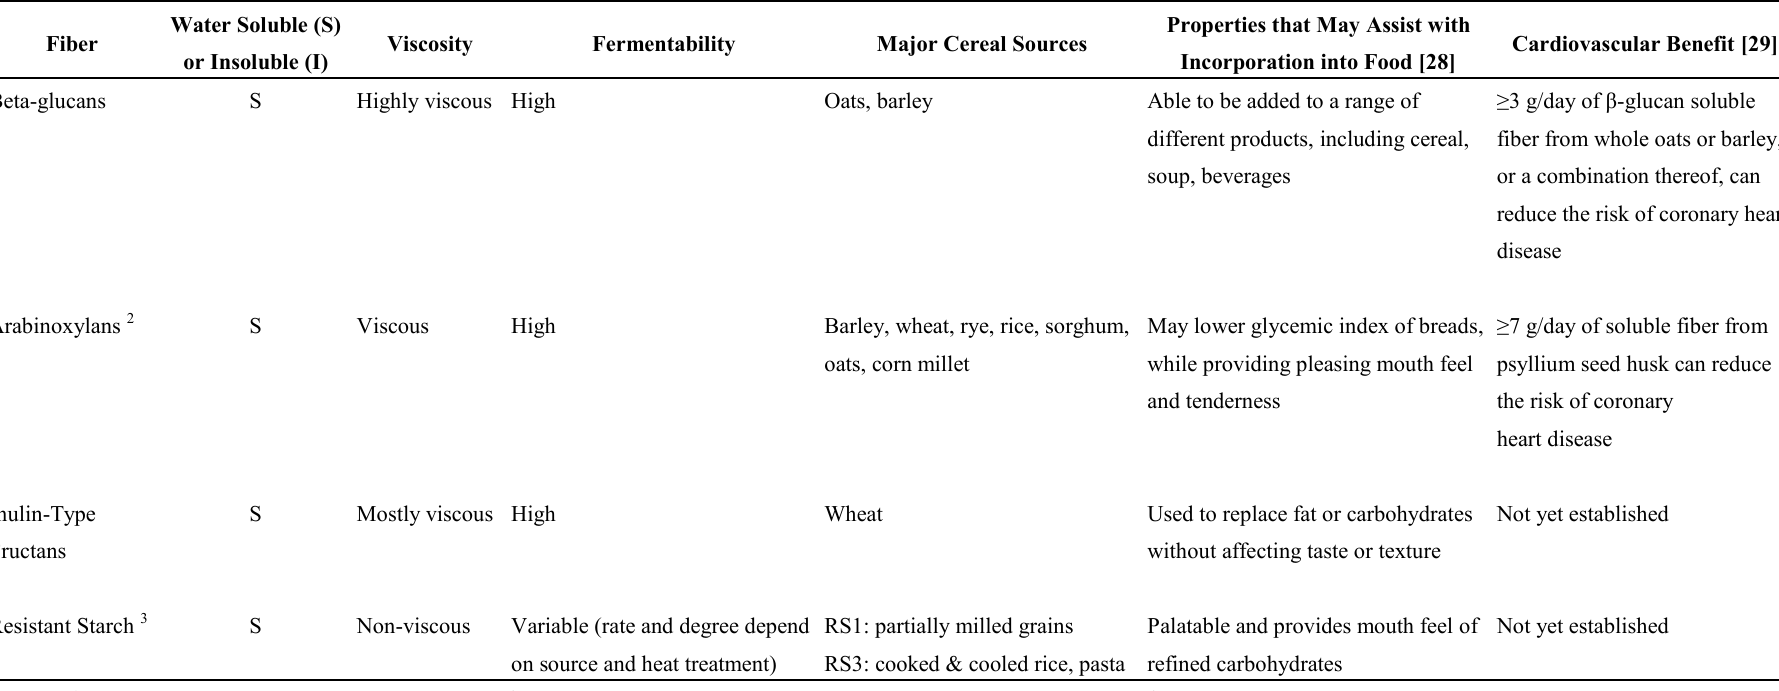
Table 1. Major dietary fibers from cereal grains with established or investigated cardiovascular health benefit 1